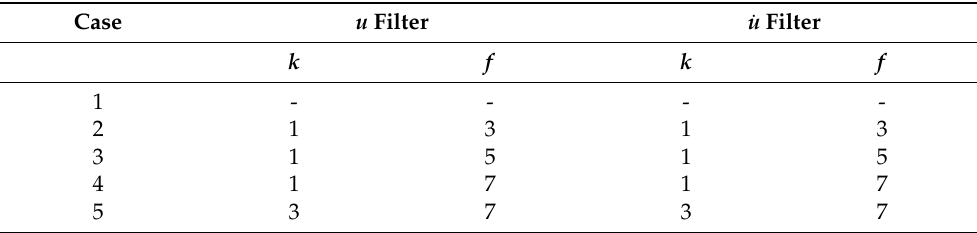
Table 1. Parameters of the Savitzky–Golay